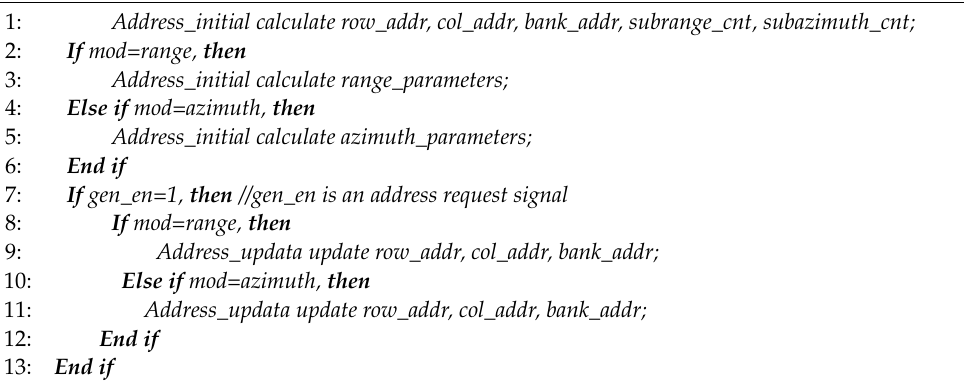
Algorithm 1. The address generation